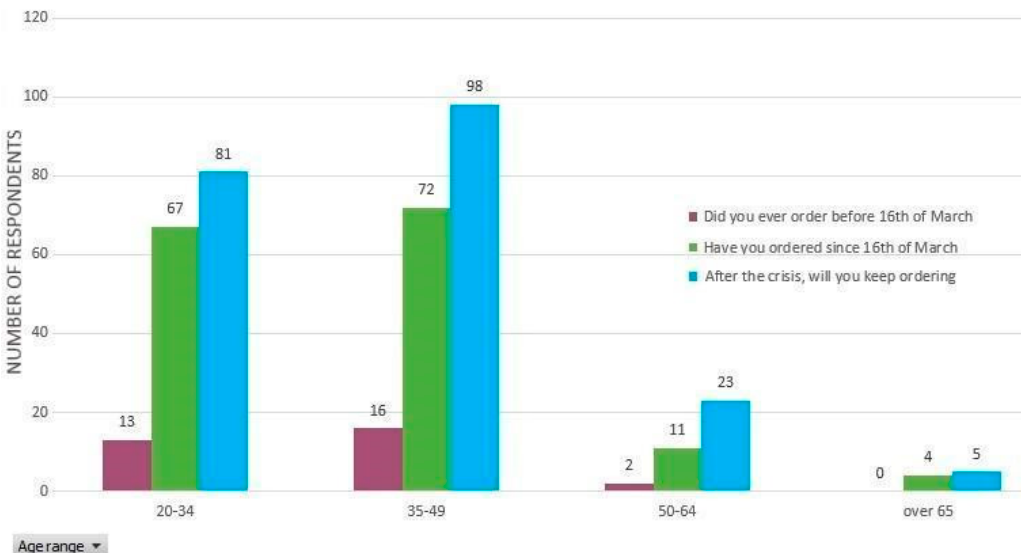
Figure 7. The clusters of those who declared that they bought or did not buy directly delivered fresh vegetables from local producers after March 16, distributed according to age categories and statements that they will keep buying or not from local producers after the COVID-19 crisis.